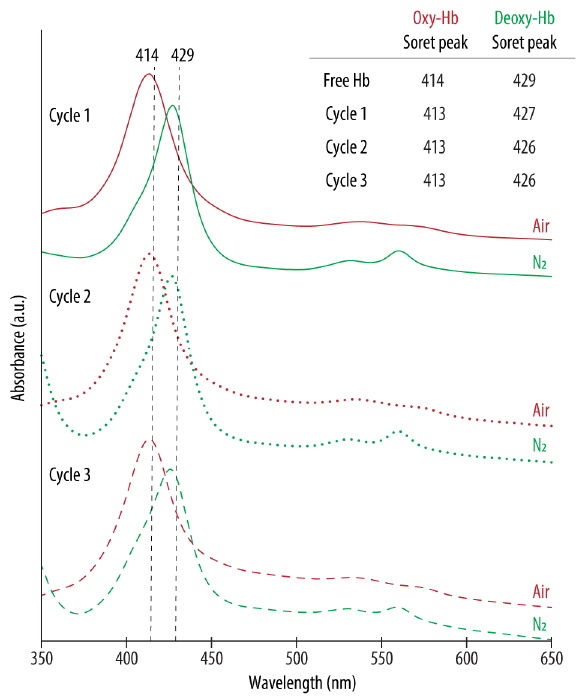
Figure 3. UV-vis spectra of oxygenated (oxy-Hb) and deoxygenated (deoxy-Hb) HbNPs obtained after successively purging with compressed air and nitrogen (N 2 ) gas. The HbNPs (HbNPs-6 TRE3 ) were prepared using a 100 mg mL − 1 Hb concentration, trehalose (TRE) at a Hb:TRE ratio of 10:1, 12.5 mg mL − 1 PLGA and 1% PVA. Table 2. Effects of the Hb:trehalose (TRE) ratio on the size, polydispersity (PDI), loading content (LC), entrapment efficiency (EE), and functionality of the resulting HbNPs- TRE 1 . Sample ID